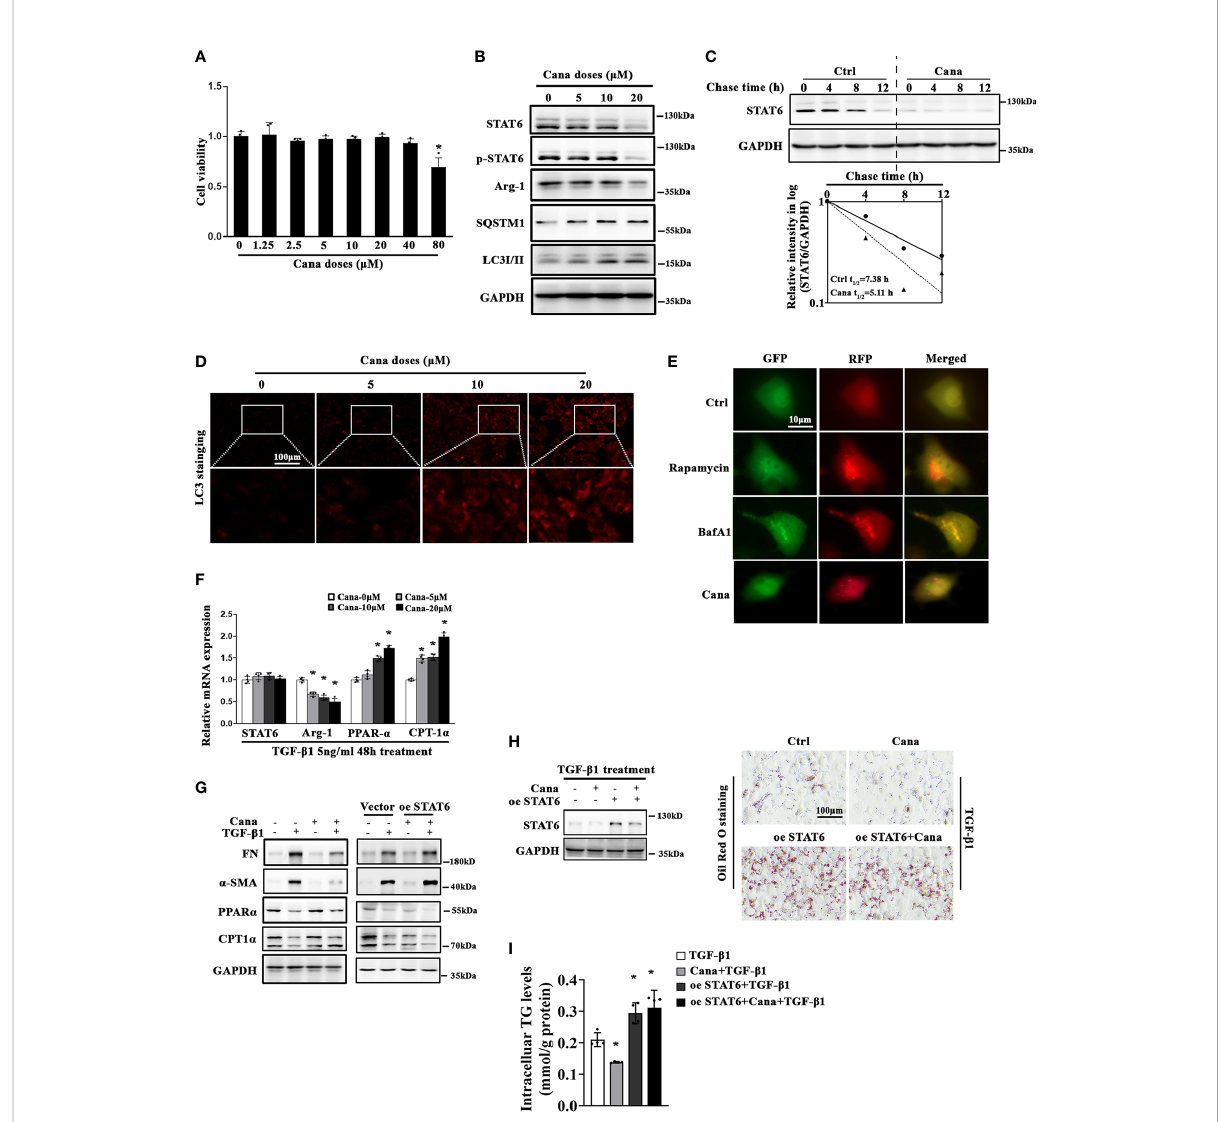
FIGURE 3 Cana causes STAT6 degradation through inducing autophagy. (A) HK2 cells were treated with the indicated doses of Cana for 48 h serum-free medium culture and cell viability was determined using MTT assay. (n = 4, * p < 0.05, Cana 0 m M vs. other doses of Cana). (B) HK2 cells were treated with Cana (0 – 20 m M) for 24 h, and then cell lysates were harvested and subjected to immunoblot analyses with the indicated antibodies. (C) To test its protein stability, the half-life of STAT6 was determined. HK2 cells were left untreated or treated with Cana (20 m M) for 24 h, and CHX (50 m M) was added at different time points. The intensity of STAT6 and GAPDH bands was quanti fi ed and plotted against the time after CHX addition. (D) HK2 cells were treated with Cana (0 – 20 m M) for 24 h and subjected to immuno fl uorescence staining of LC3. (E) HK2 cells were transfected with a tandem mRFP-GFP-LC3 construct for 24 h and then either left untreated or separately treated with rapamycin (1 m M), BafA1 (100 nM), or Cana (40 m M) for 24 h. Representative micrographs of the indicated cells are shown. (F) The mRNA levels of STAT6, Arg-1, PPAR a , and CPT-1 a in HK2 cells treated with Cana (0 – 20 m M) for 24 h were measured by qPCR. (* p < 0.05, Cana 0 m M vs . other doses of Cana). (G – I) HK2 cells were transfected with vector or plasmid of STAT6 overexpression. Followed by 24 h serum-free medium culture, cells were treated with TGF- b 1 (5 ng/ml) for another 24 h and cotreated with or without Cana (20 m M). (G) Immunoblot analysis was conducted with the indicated antibodies. (H) Immunoblot analyses were employed to con fi rm the ef fi ciency of overexpressing STAT6. Representative microphages showed the Oil Red O staining in HK2 cells with the indicated treatments. (I) TG content was determined enzymatically. (n = 4, * p < 0.05, TGF- b 1 vs. TGF- b 1 with other